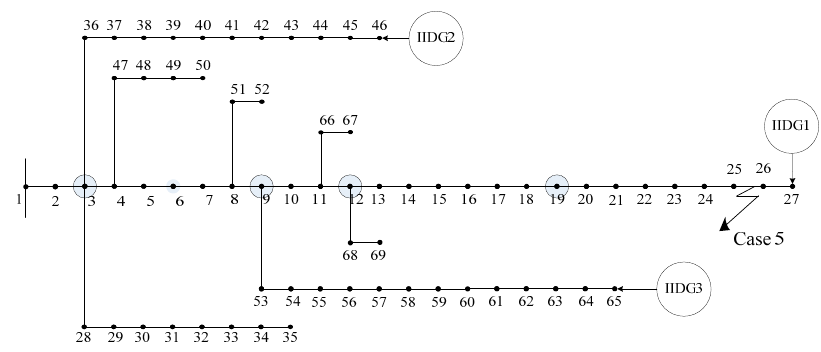
Figure 8. Modified IEEE 69-node distribution benchmark.